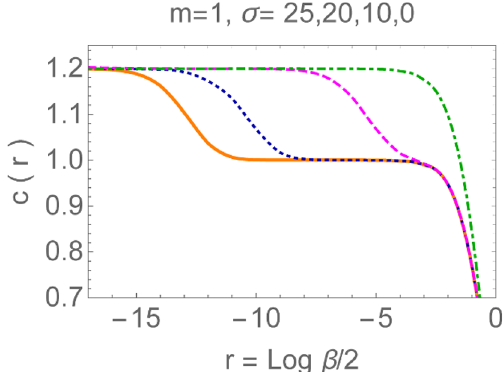
Figure 1 . The TBA scaling function of the SU (3) 2 -HSG model for di(cid:11)erent values of (cid:27) .